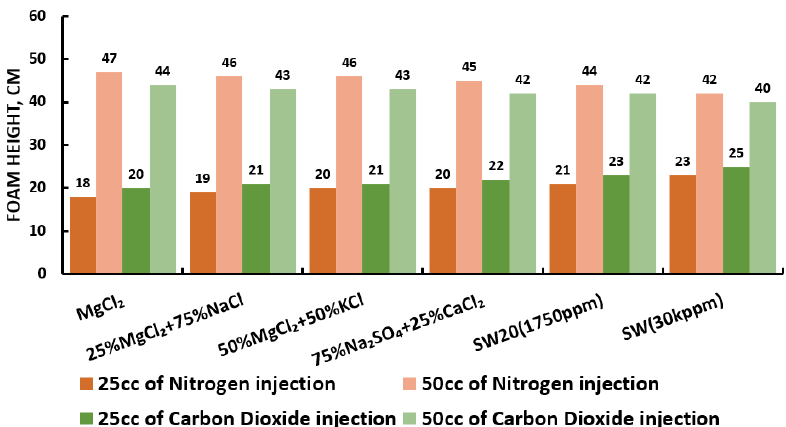
Figure 30. Surfactants screening: formability test—alpha-foamer 25 ◦ C.